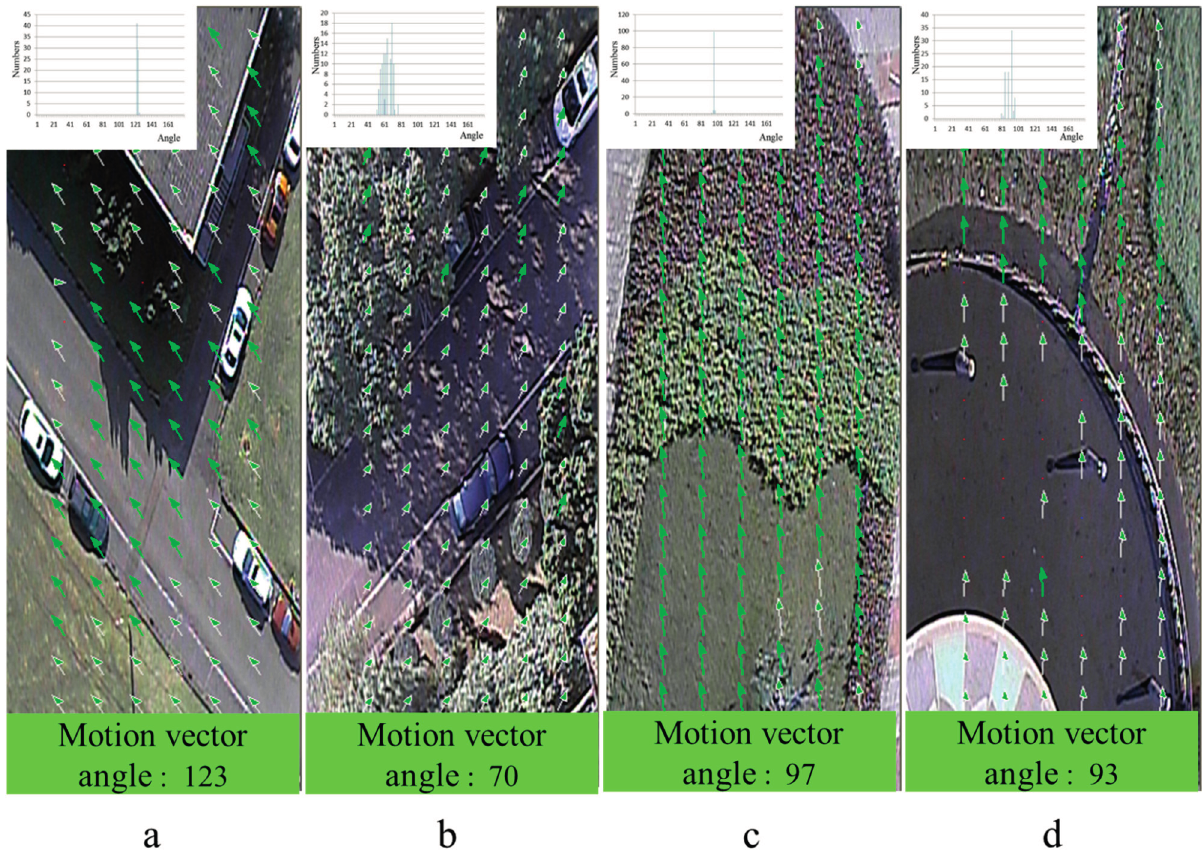
Figure 8. Different detection results under various